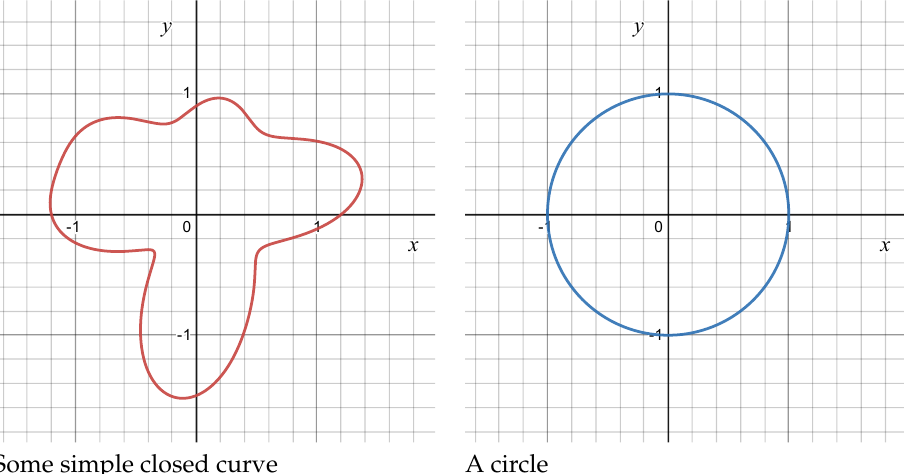
Figure 3. Any simple closed curve is homeomorphic to a circle, i.e., these two figures are essentially the same as a topological